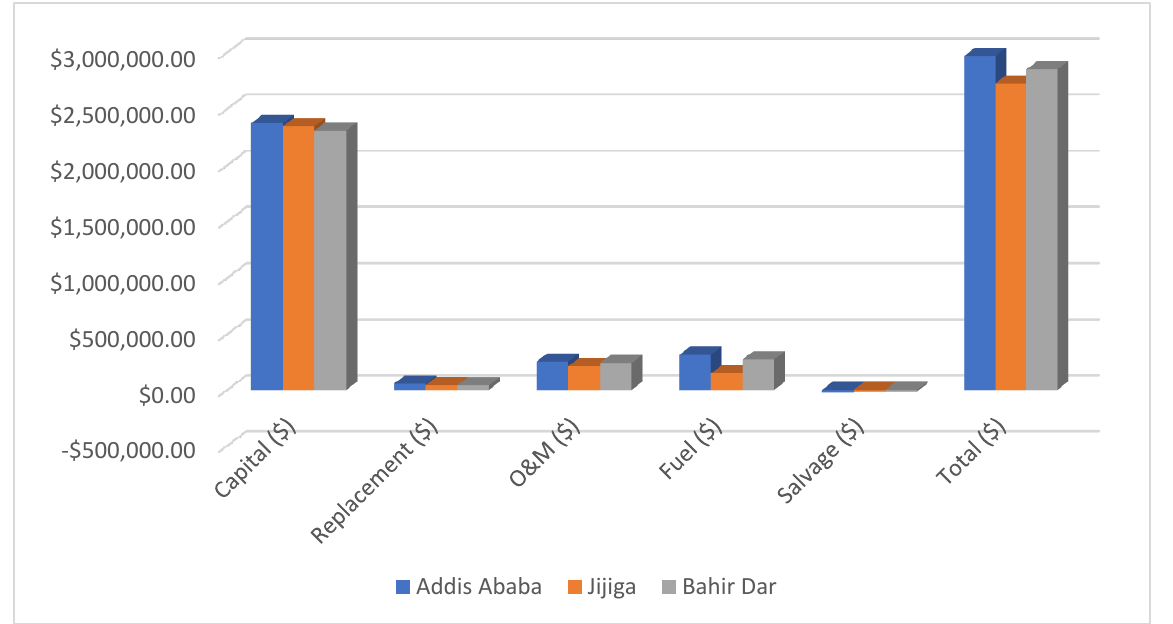
Figure 8. Cost summary of the PV/DG/ZnBr system.